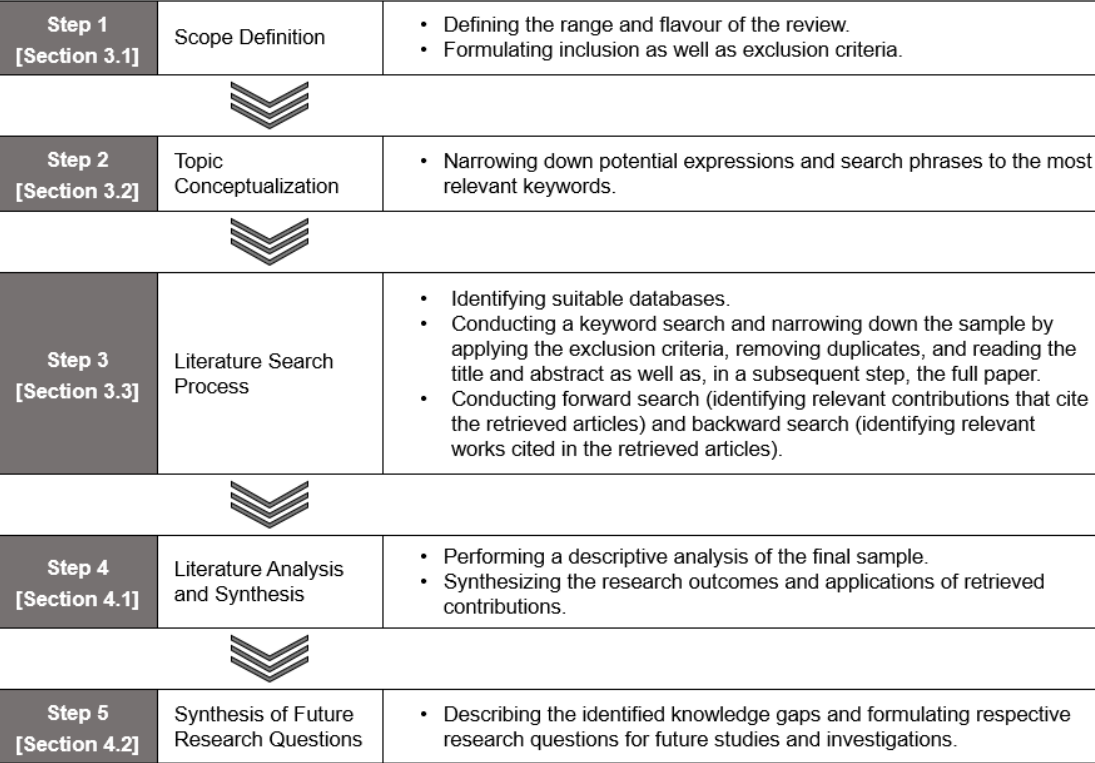
Figure 1. Applied Research Methodology (own elaboration with adaptations from